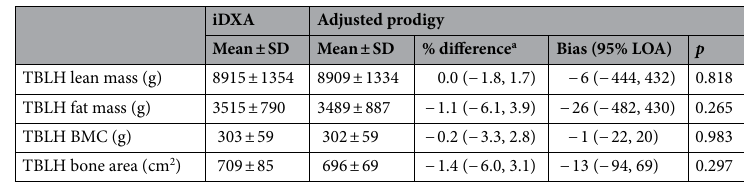
Table 5. Total body less head (TBLH) body composition estimates and results from Bland–Altman analysis comparing body composition parameters from the iDXA and adjusted Prodigy values. BMC bone mineral content. a Percentage difference (95% CI) in body composition values in reference to the values obtained from the GE Lunar